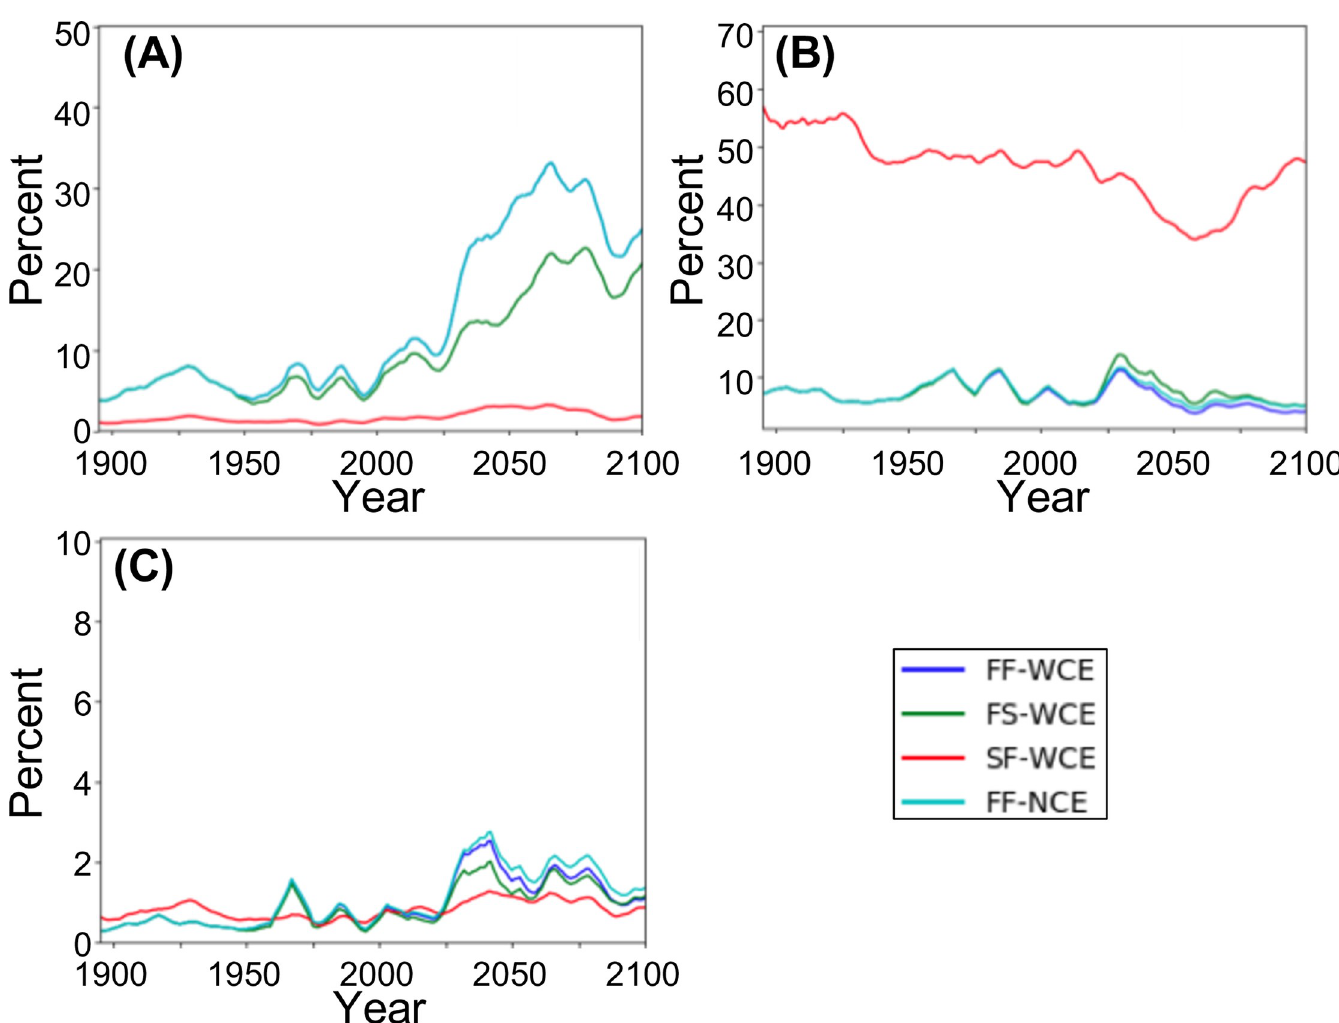
Fig 7. Fire results by scenario as a percentage of total area. (A) AWF (Area with fire; the area of all grid cells experiencing any fire); (B) FAB (Fraction area burned; the fraction of are burned in grid cells with fire); and (C) TAB (Total area burned; the sum of (AWF � FAB) over all grid cells). (FF-WCE: full fire, with CO 2 fertilization effect; FS-WCE: with fire suppression, with CO 2 fertilization effect; SF-WCE: with stochastic ignitions, with CO 2 fertilization effect; and FF-NCE: full fire, with no fertilization effect. Results smoothed using triangle smoothing +/- 8